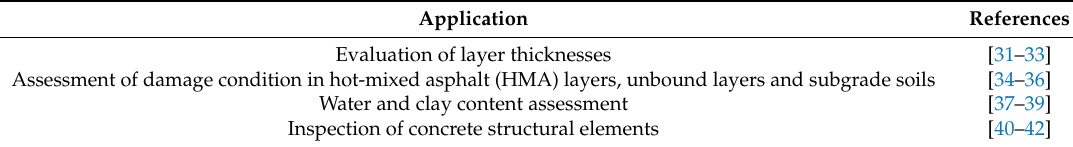
Table 2. Main GPR applications in road